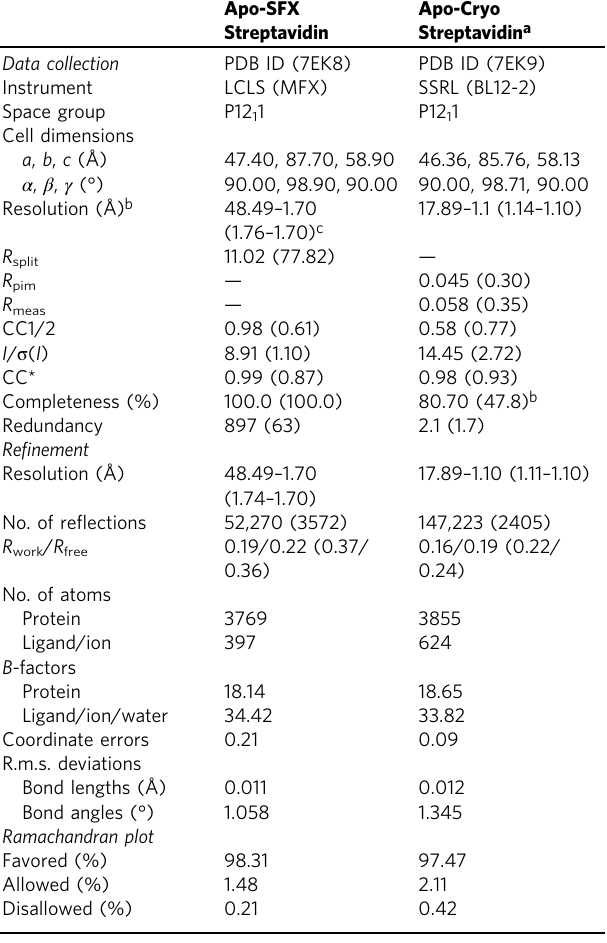
Table 1 Data collection and re fi nement